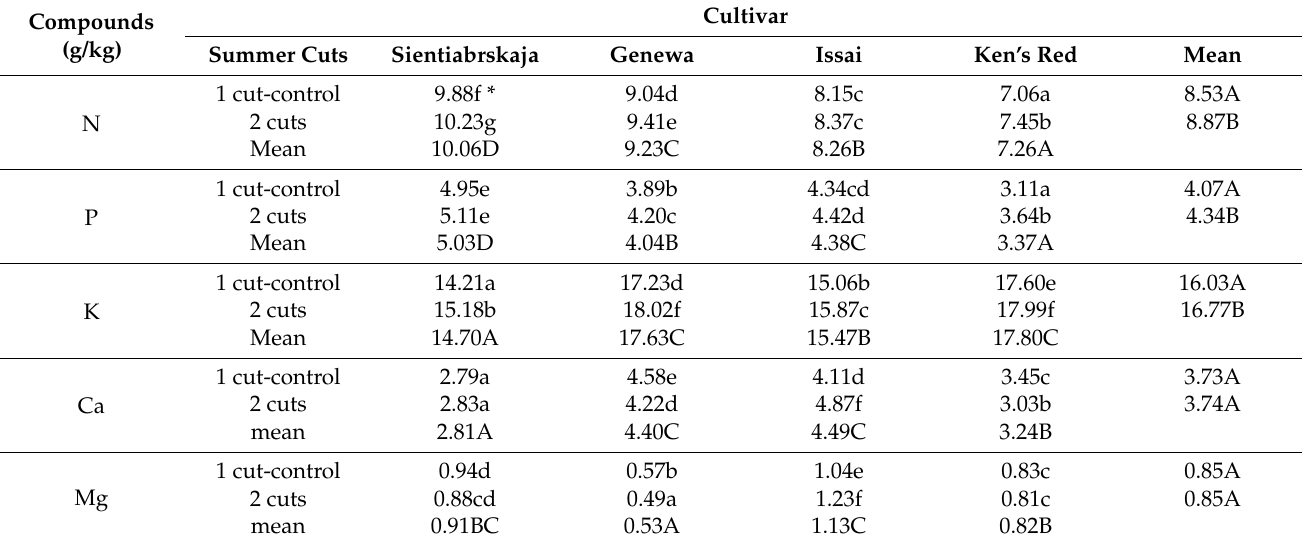
Table 2. The contents of macronutrients in Actinidia fruits depending on the number of summer cuts.